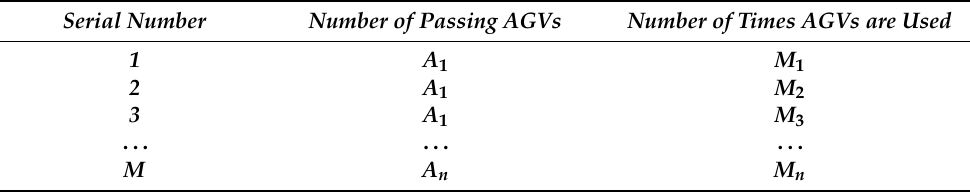
Table 3. Parameters of the K-L Algorithm.